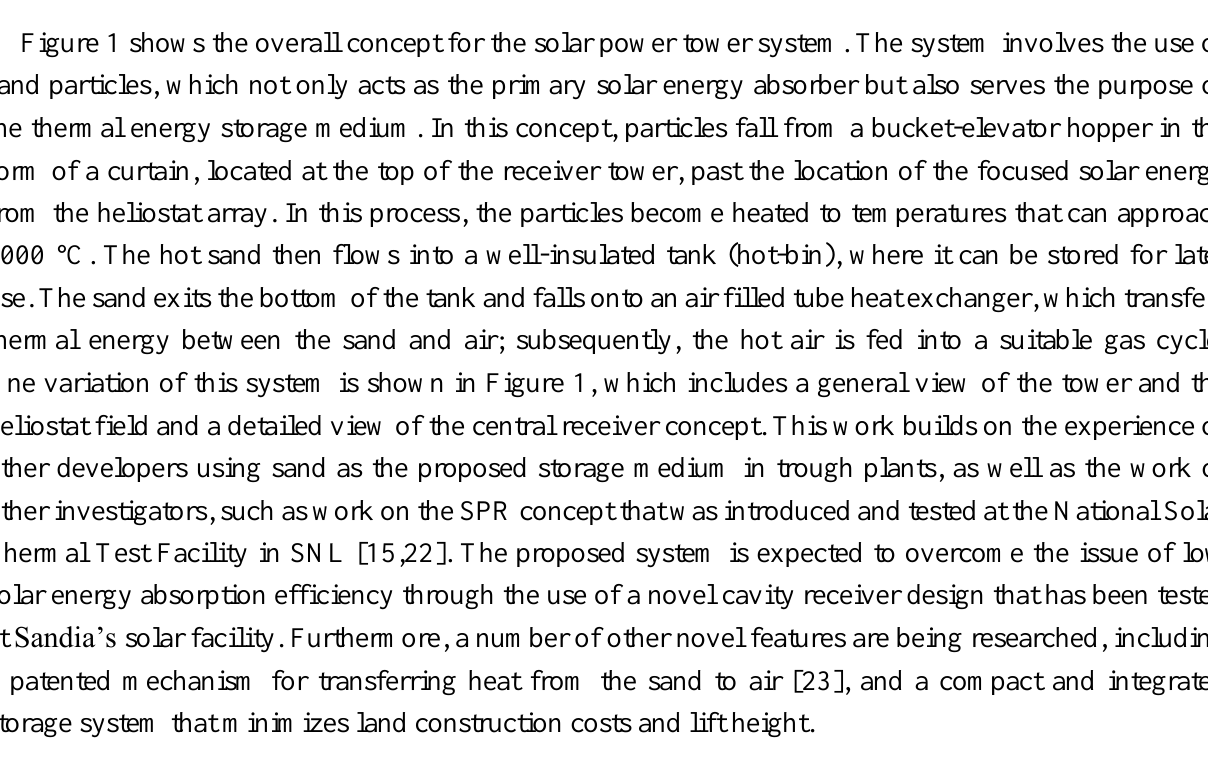
Figure 1. Overview of the solid particle receiver (SPR) concept: ( a ) field layout of the pilot scale demonstration and ( b ) generic layout of components within the